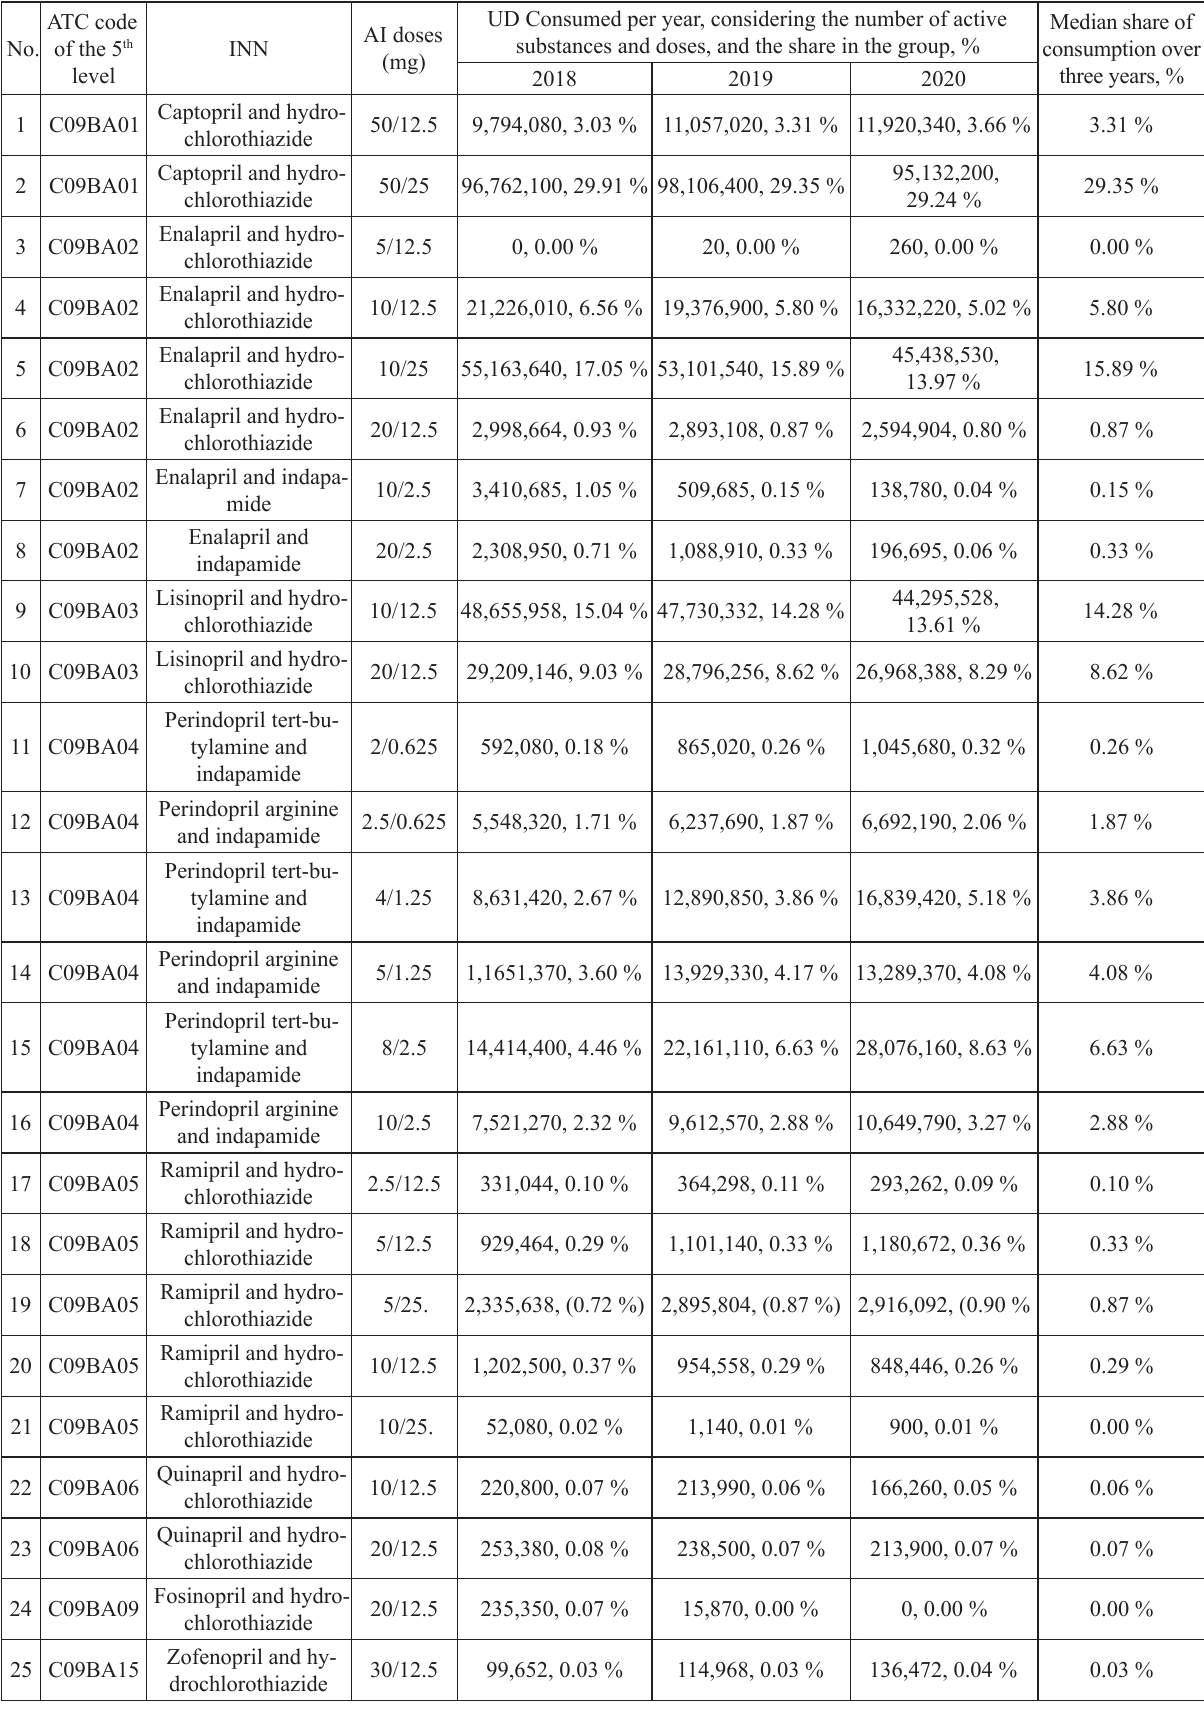
Consumption of fixed-dose combinations of iACE and diuretics in Ukraine in